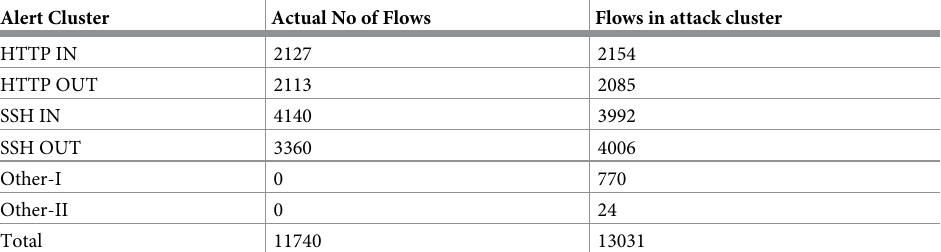
Table 8. Clustering malicious flows in second stage process—Sperotto’s